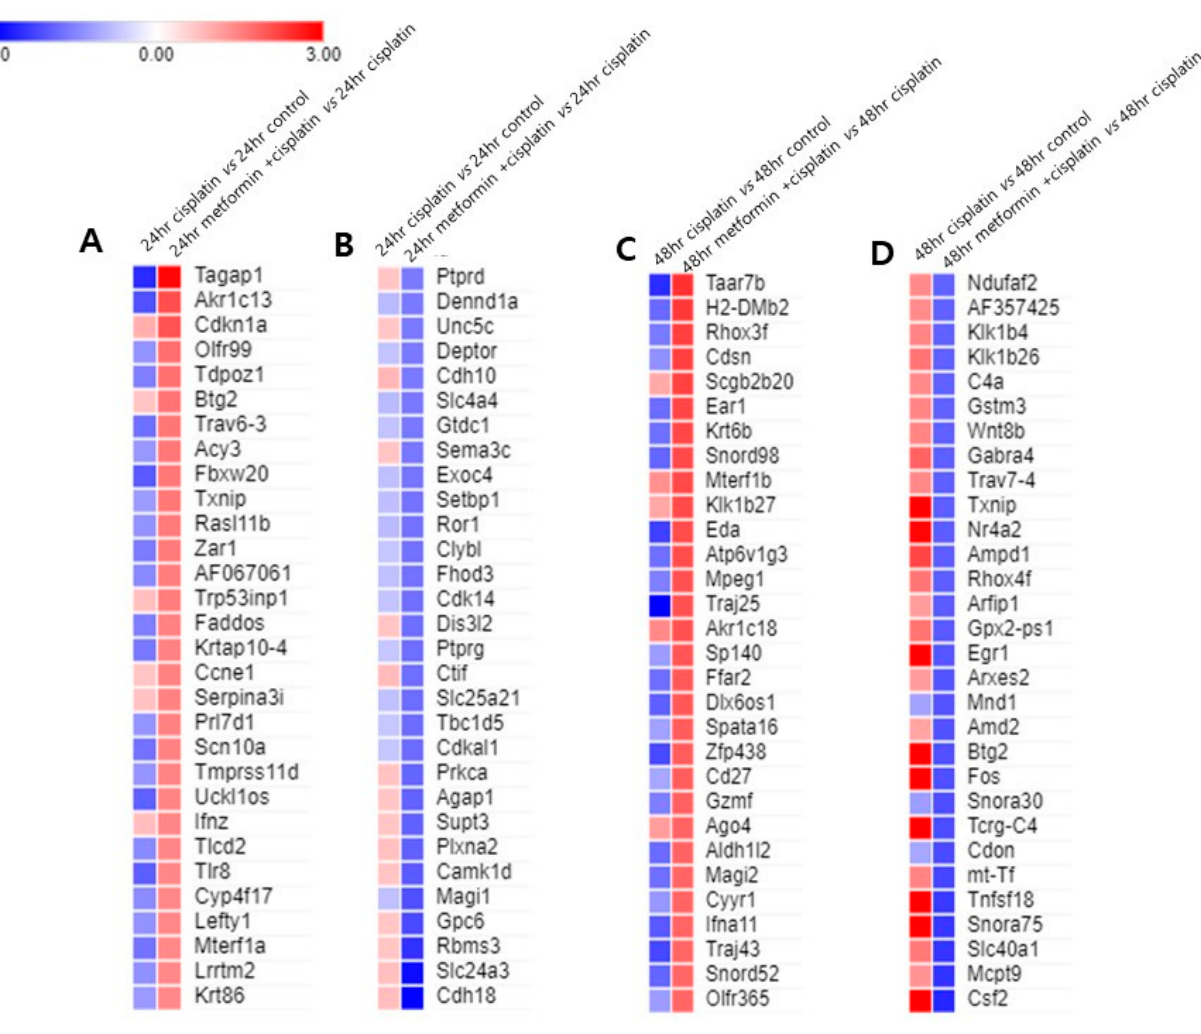
Figure 4. Metformin pretreatment-triggered gene expression changes compared to cisplatin group. ( A ). The expression level of top 30 upregulated genes in 24 h metformin-pretreated group were compared with those of 24 h cisplatin group. Pretreatment of metformin for 24 h increased the expression of Tagap1, Akr1c13, Trav6-3, Fbxw20, Scn10a, Uckl1os, Tlr8, and Mterf1a more than |fold-change| ≥ 1.5 while significantly decreasing same genes with |fold-change| ≥ 1.5 in cisplatin alone group. ( B ). The expression level of top 30 downregulated genes in 24 h metformin-pretreated group were not in accord with elevated genes in 24 h cisplatin group. ( C ). Pretreatment of metformin for 24 h and then exposure to cisplatin for 48 h (48 h metformin-pretreated group) increased the expression of Taar7b, H2-DMb2, Rhox3f, Ear1, Krt6b, Snord98, Eda, Atp6v1g3, Mpeg1, Traj25, Ffar2, Dlx6os1, Zfp438, Gzmf, Aldh1l2, Magi2, Ifna11, Tfaj43, and Snord52 more than |fold-change| ≥ 1.5 while significantly decreasing same genes with |fold-change| ≥ 1.5 in 48 h cisplatin group. ( D ). Likewise, in 48 h metformin-pretreated group, the expression of Csf2, Slc40a1, Snora75, Tnfsf18, Tcrg-C4, Fos, Btg2, Egr1, Gpx2-ps1, Rhox4f, Ampd1, Nr4a2, Txnip, Gabra4 and Klk1b26 decreased more than |fold-change| ≥ 1.5 while significantly increasing same genes with |fold-change| ≥ 1.5 in the 48 h cisplatin group. Red indicates transcripts with high expression, and blue indicates transcripts with low expression.